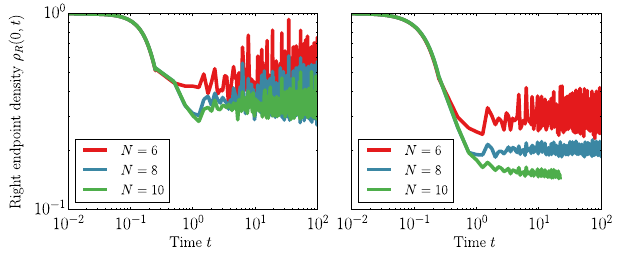
FIG. 19. Height of the peak in ρ R of S z 0 ð t Þ obtained for Hamiltonians H 3 (left) and H 3 þ H 0 4